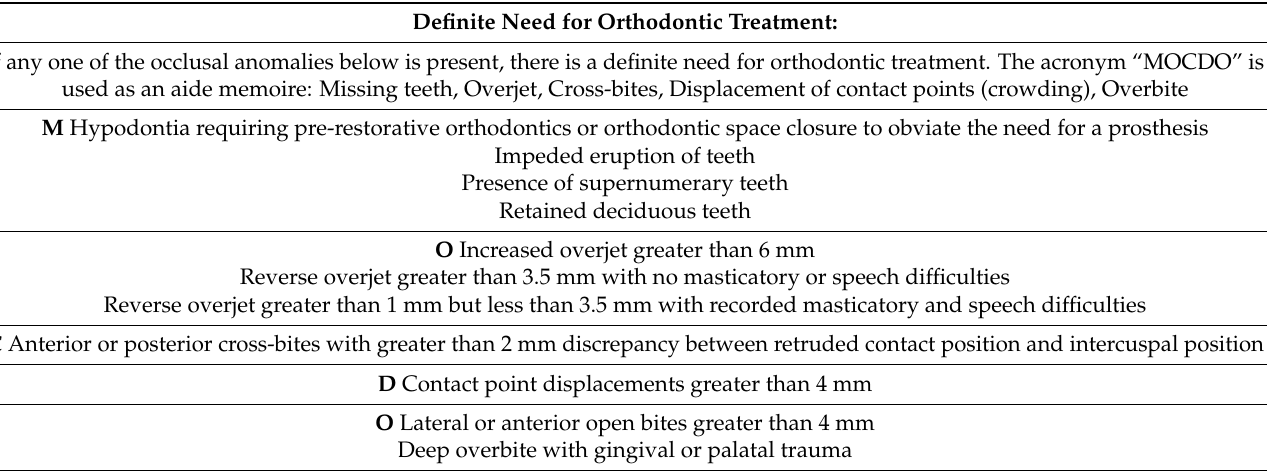
Table 1. The Modified Dental Health Component of IOTN